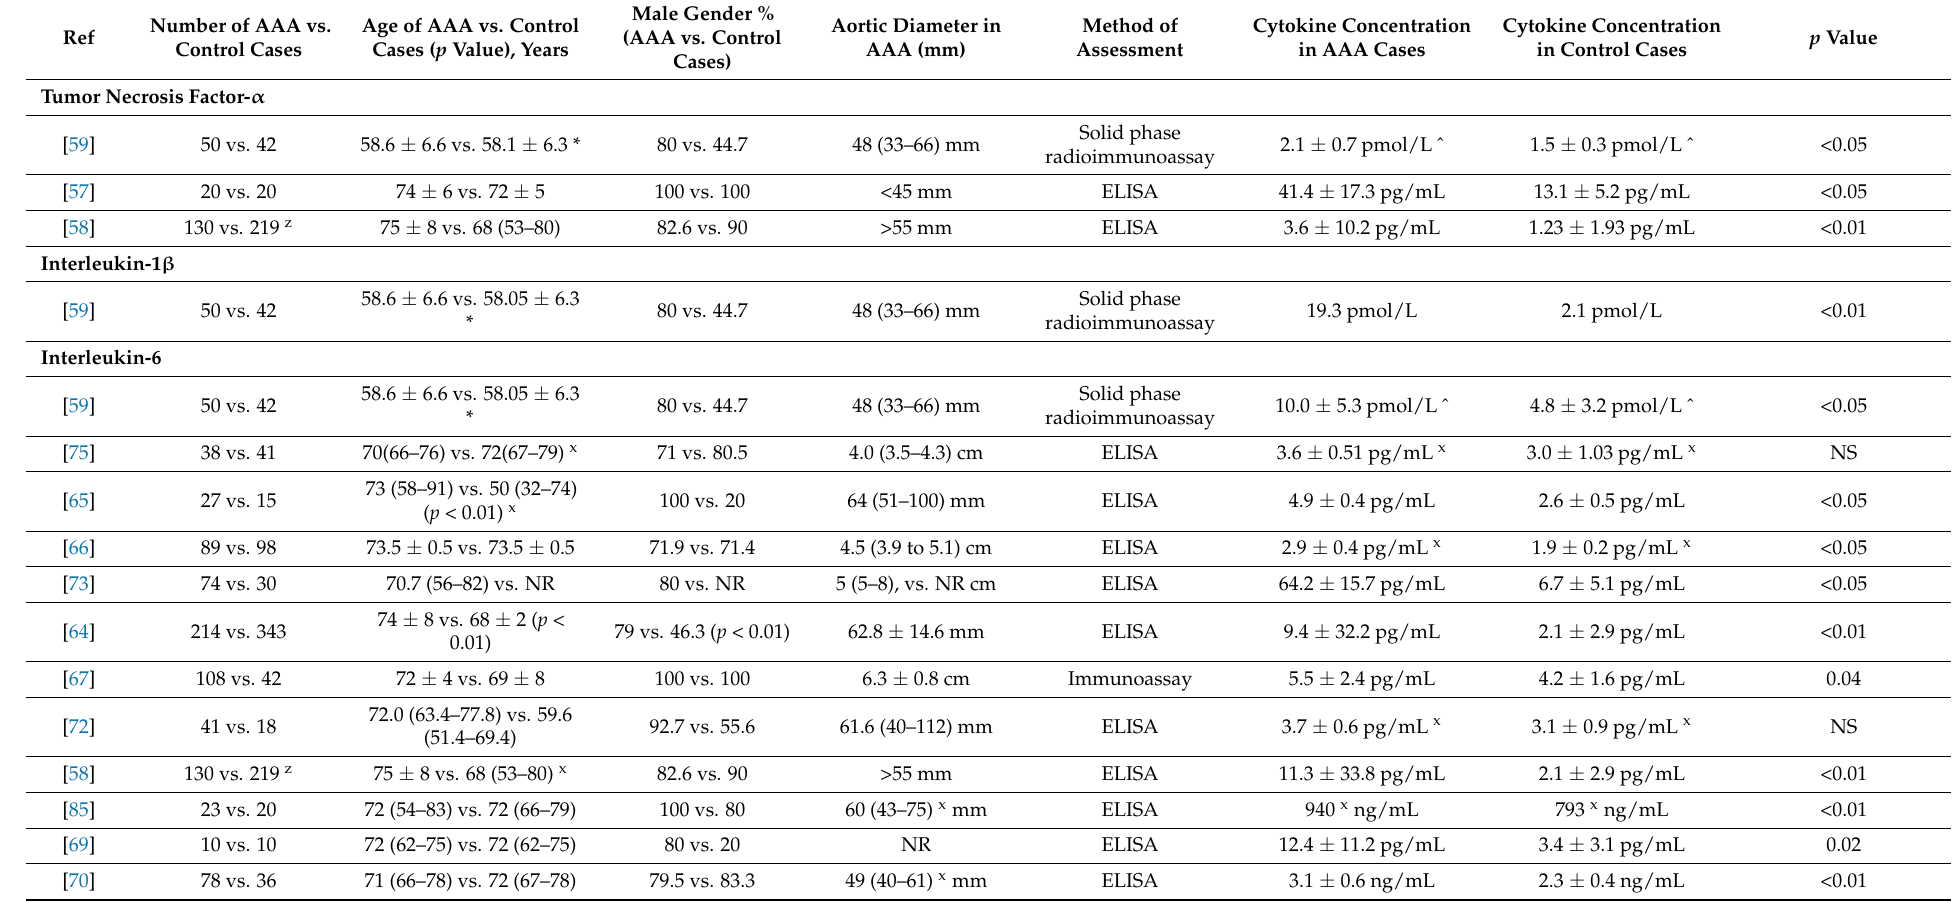
Table 6. Examples of clinical studies comparing circulating tumor necrosis factor or interleukin serum concentrations in AAA and control